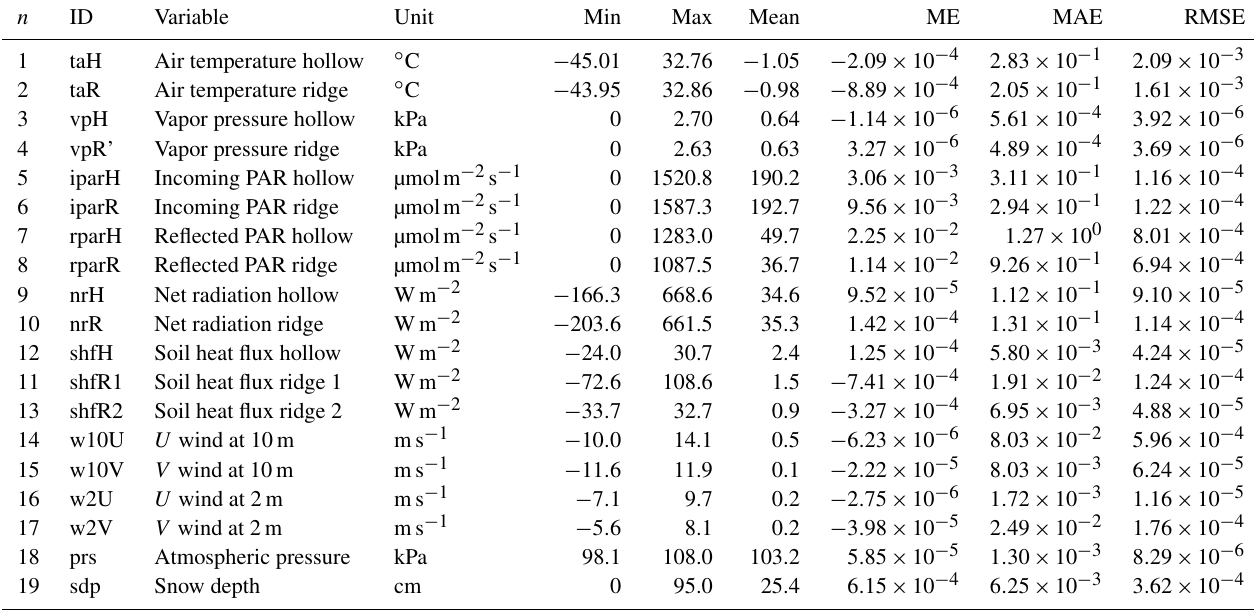
Table 3. Average, minimal, and maximal errors for model data for 2010–2019. ME: mean error; MAE: mean absolute error; RMSE: root- mean-squared